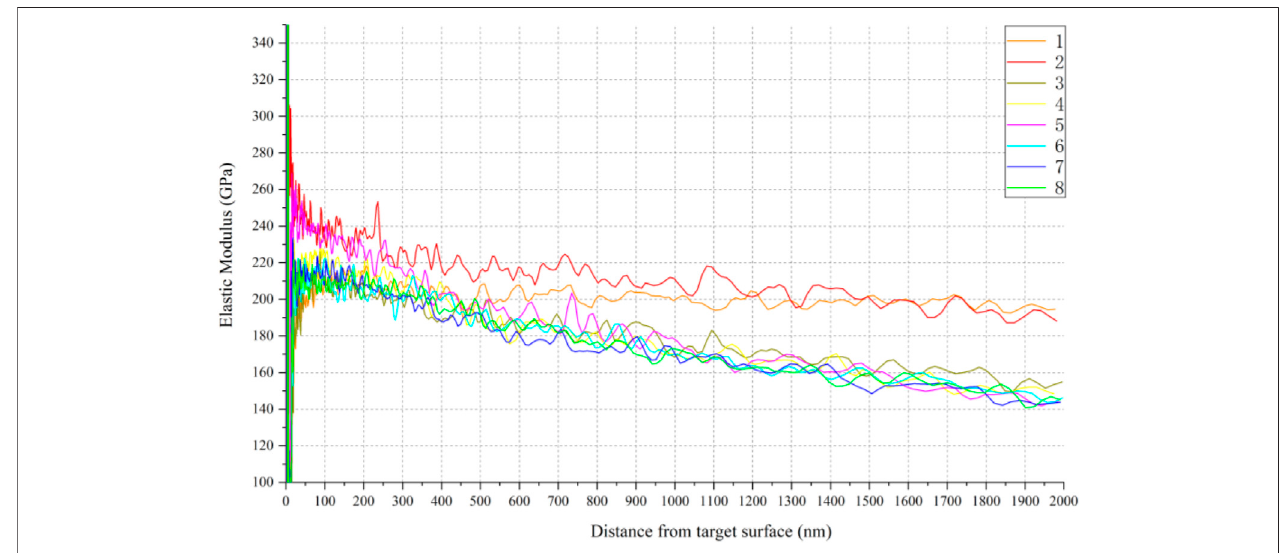
FIGURE 5 | Elastic modulus test